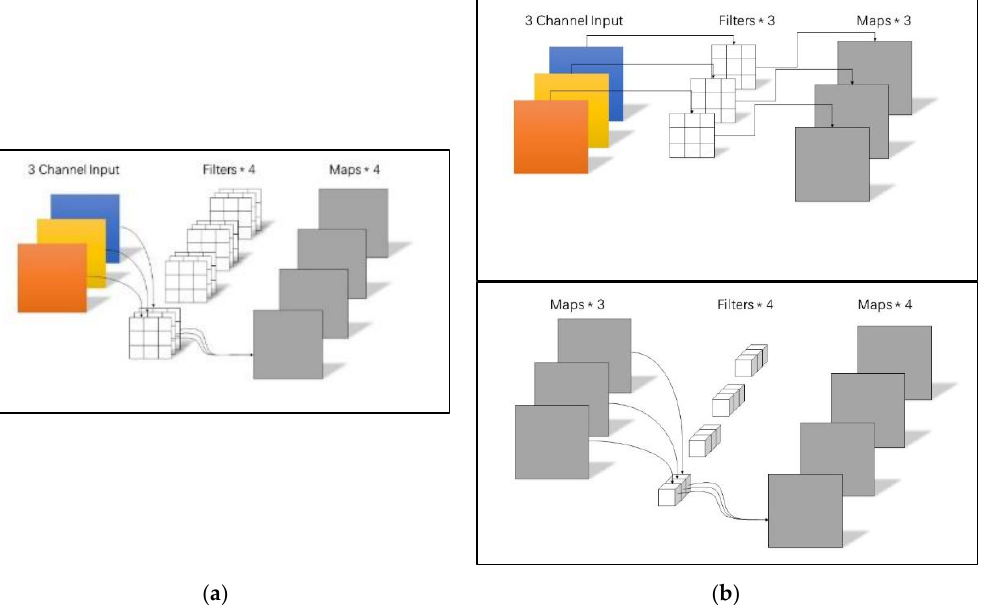
Figure 5. The difference between standard convolution and depthwise separable convolution. ( a ) Standard convolution; ( b ) Depthwise separable convolution.